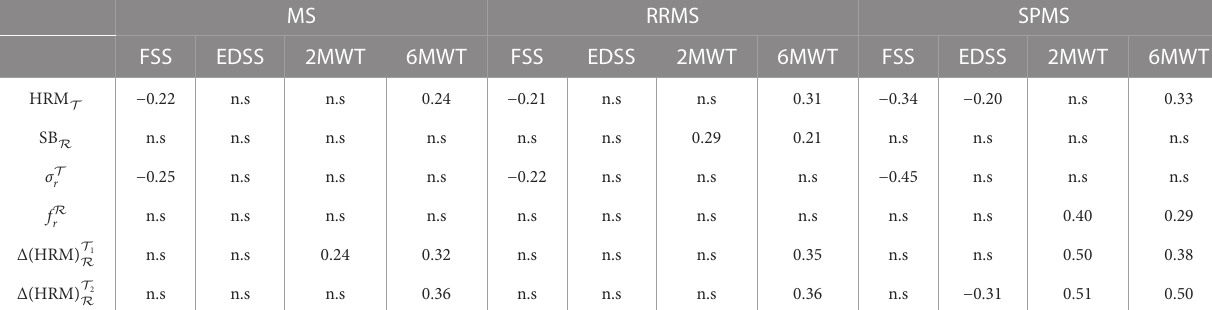
TABLE3 Partialcorrelationcoefficient r betweenANSparametersandclinicaloutcomes.